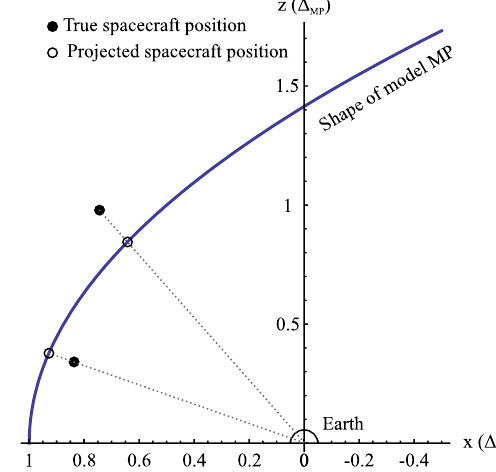
Figure 7. Illustration of the model magnetopause used as a refer- ence magnetopause for data presentation. The dotted lines show ex- ample projections of two different currents from their true location to the location at the reference